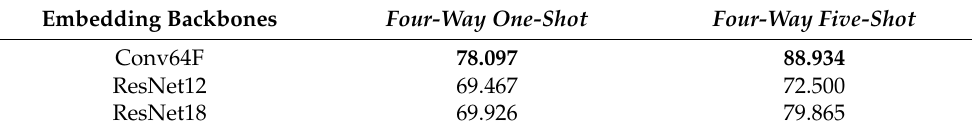
Table 4. Comparison results on different embedding backbones (%) (the best results in bold).